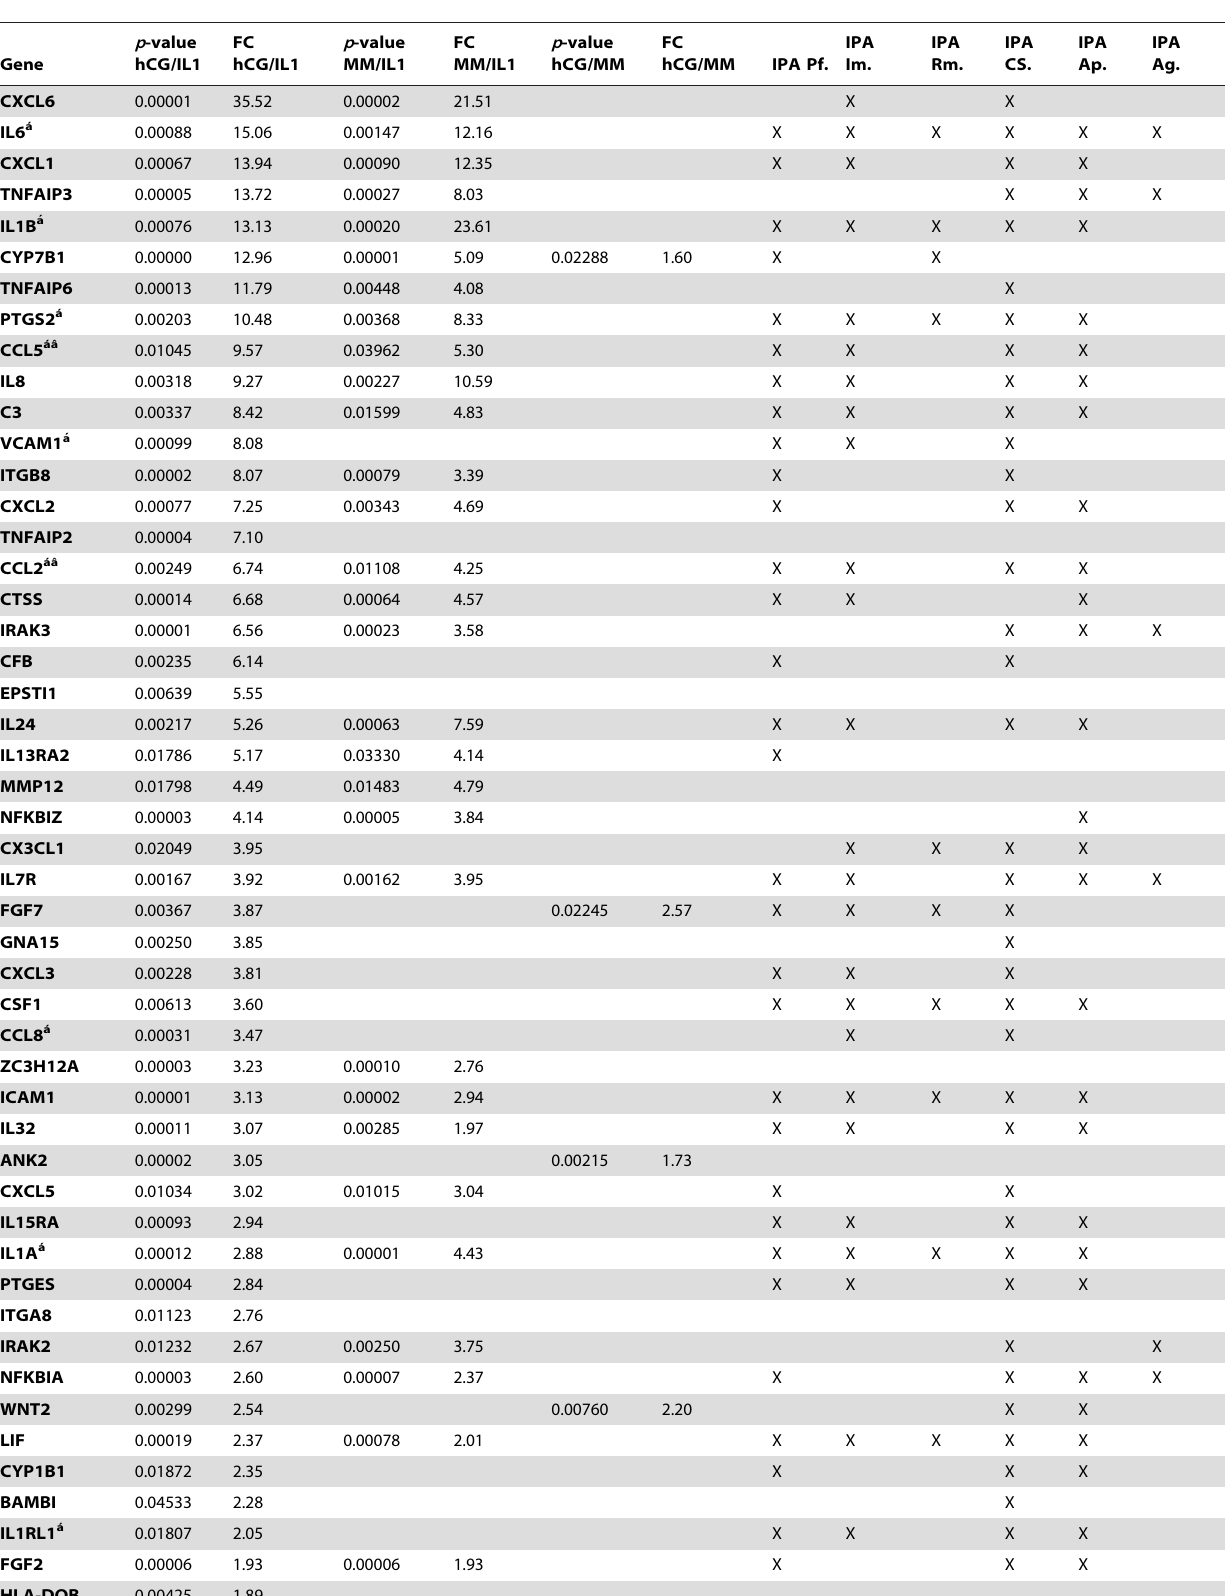
Table 2. Genes up-regulated after in vitro treatment of human endometrium stromal cells.